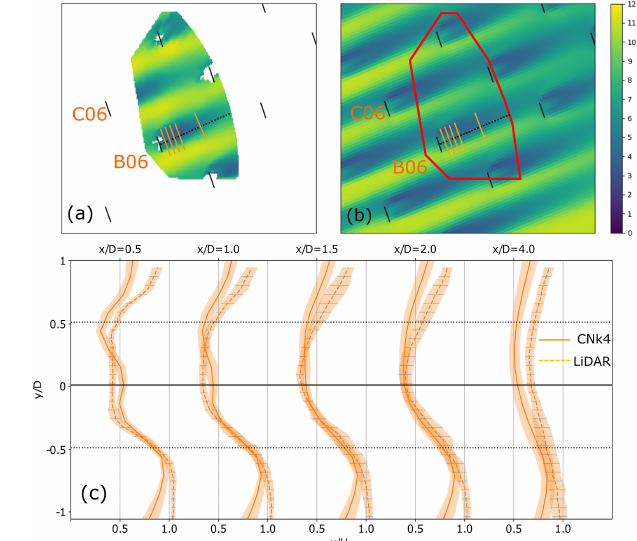
Figure 19. Comparison of LES time-averaged velocity (b) against lidar wake measurements (a) for case CNk4 1 and turbine B06. (c) Comparison of velocity wake deficit at downstream locations from turbine B06. Line at y/D = 0 is perpendicular to the turbine orientation from SCADA data. Shaded area represents 95% confi- dence interval on the mean.